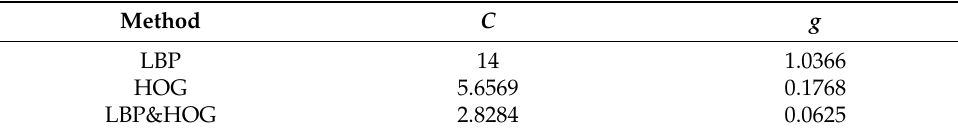
Table 4. The values of the optimized parameters.